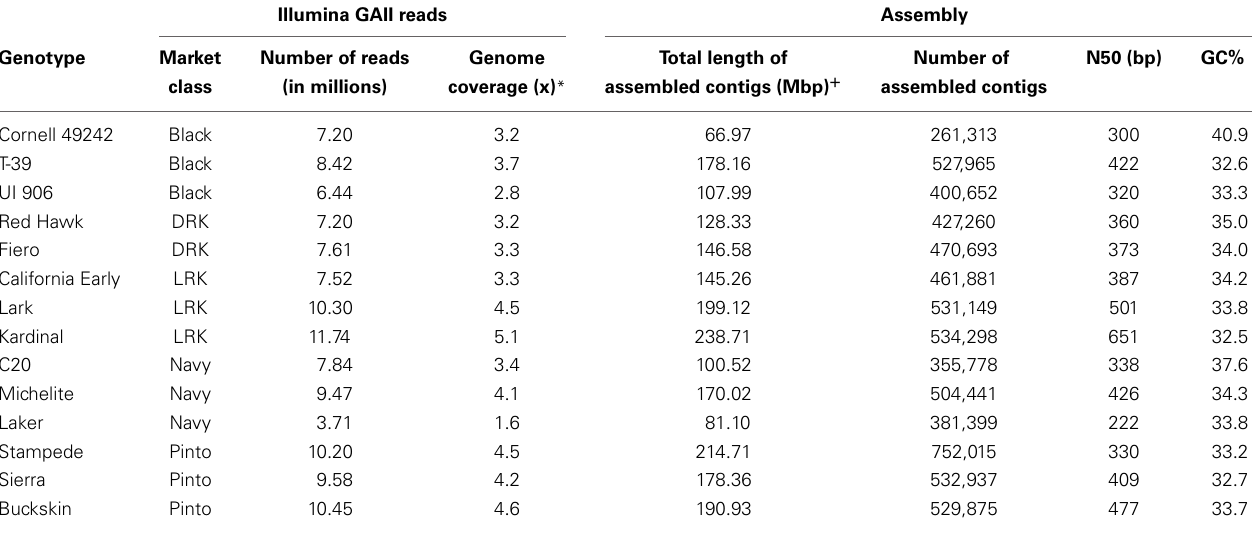
Table 3 | Illumina paired-end reads information and contig information after the de novo assembly .